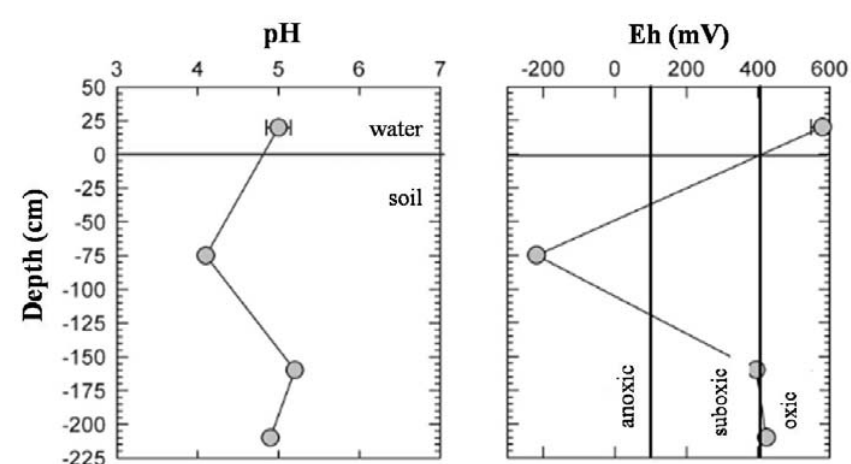
Figure 5. Values of pH and potential redox (Eh) of the peatland profile from Pau de-Fruta SPA.